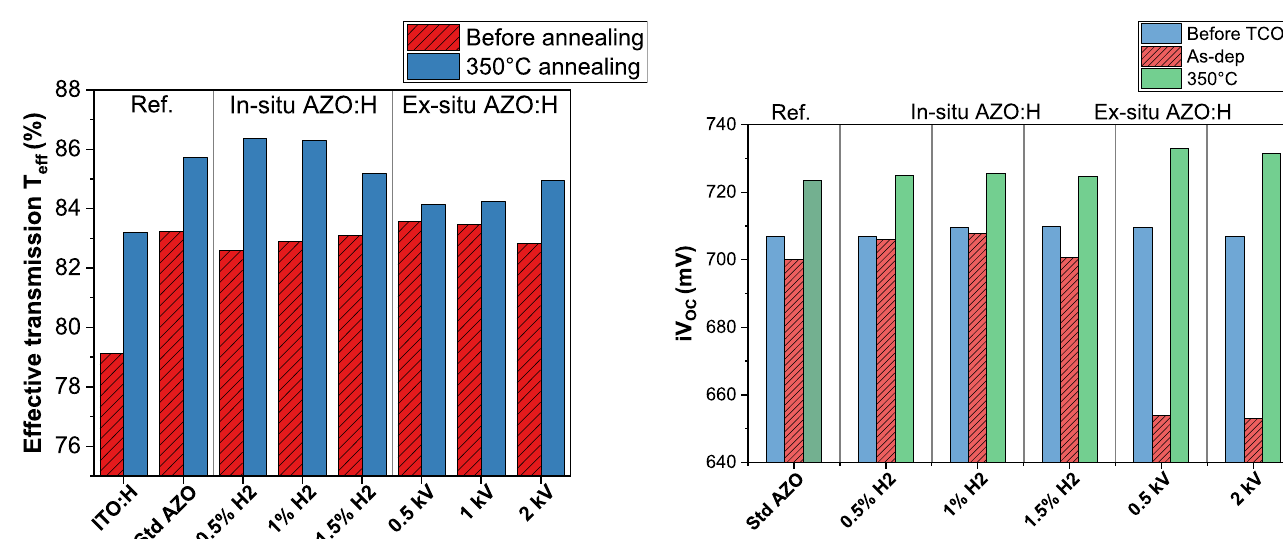
Fig. 6. Evolution of effective transmission depending of TCO hydrogenation, after deposition/hydrogenation and after anneal- ing at 350 ° C.